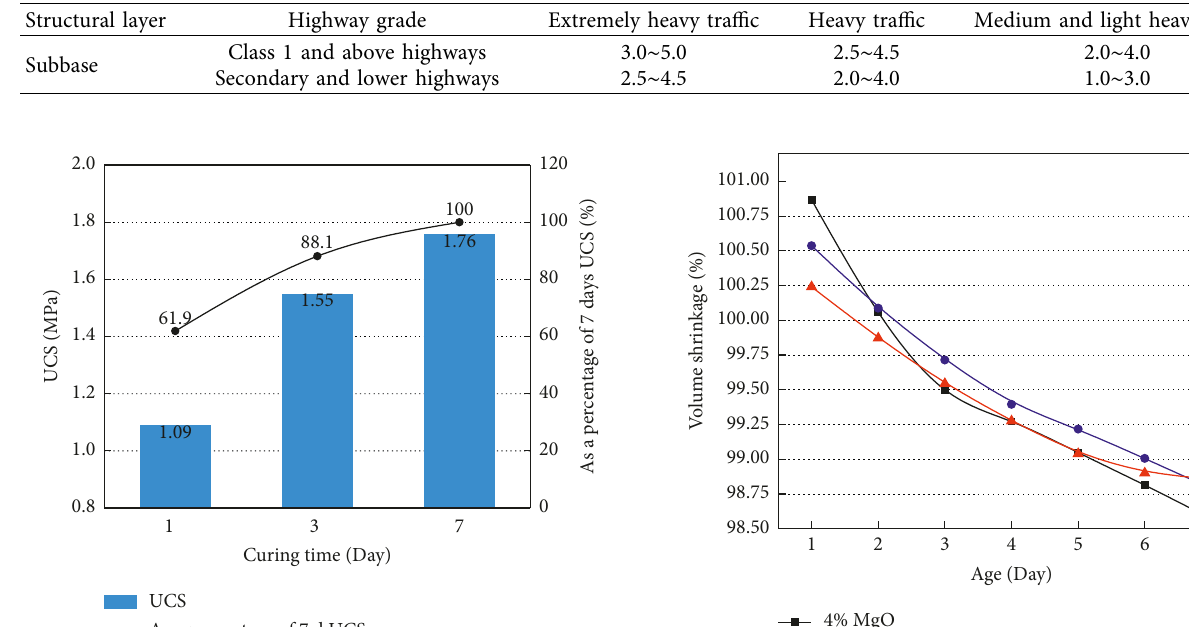
Table 7: Chinese cement-based material 7 days UCS standard (MPa).